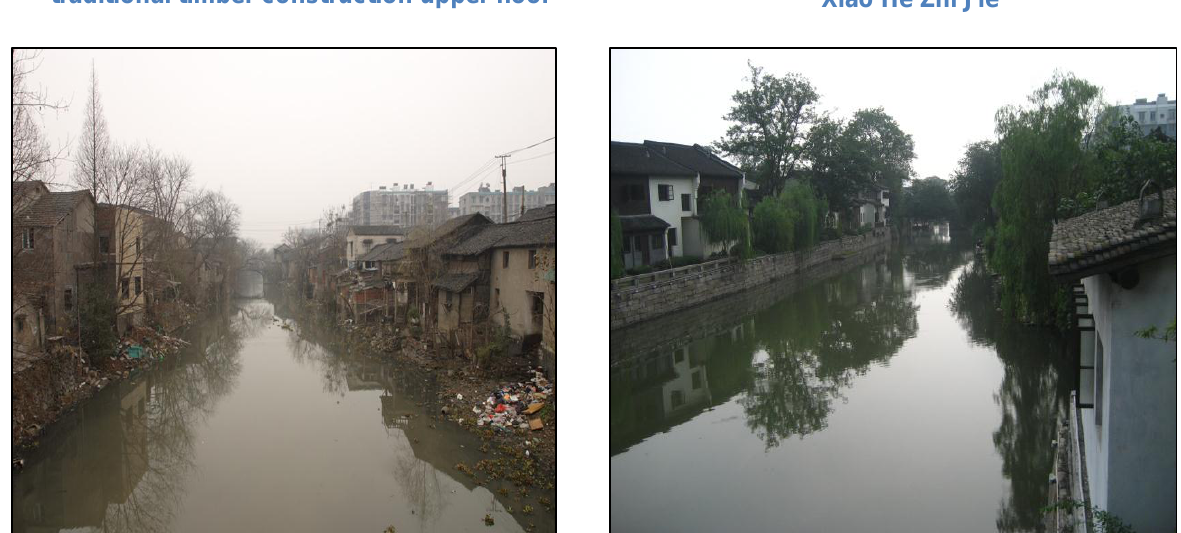
Figure 3 Dwellings along the Xiao He before renovation